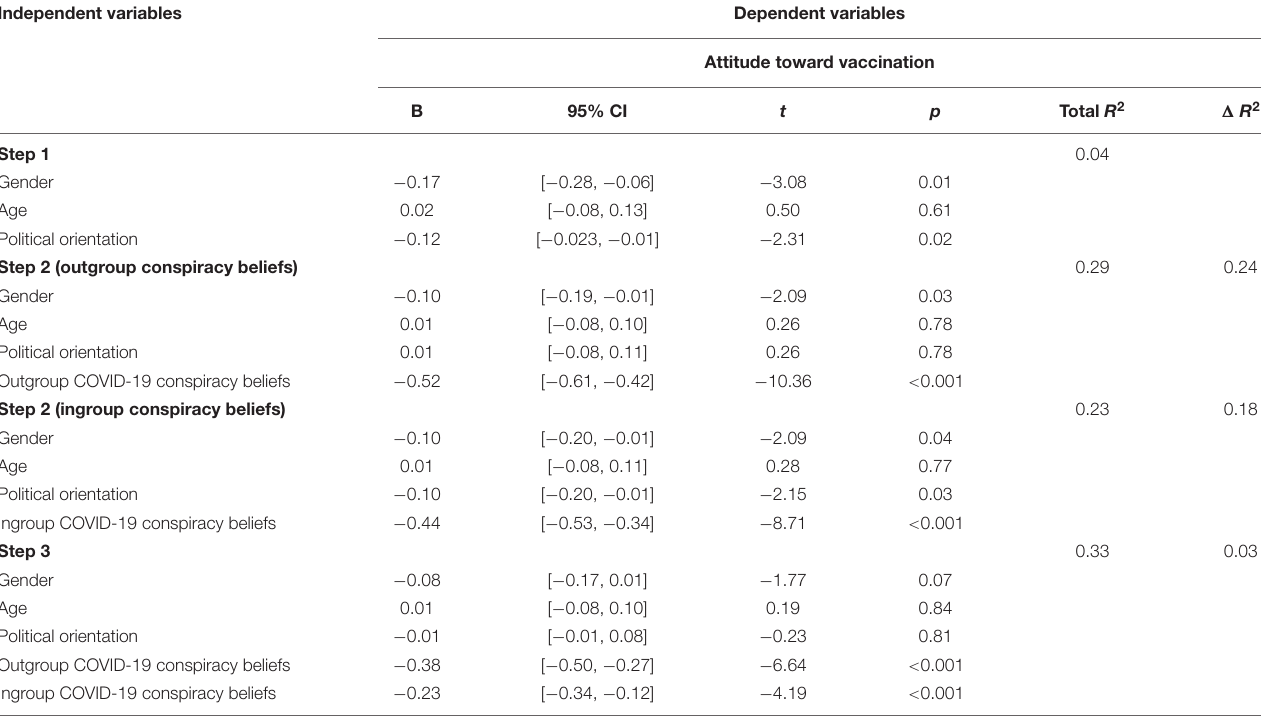
TABLE 2 | Hierarchical regressions on attitude toward vaccination (study 1). Independent